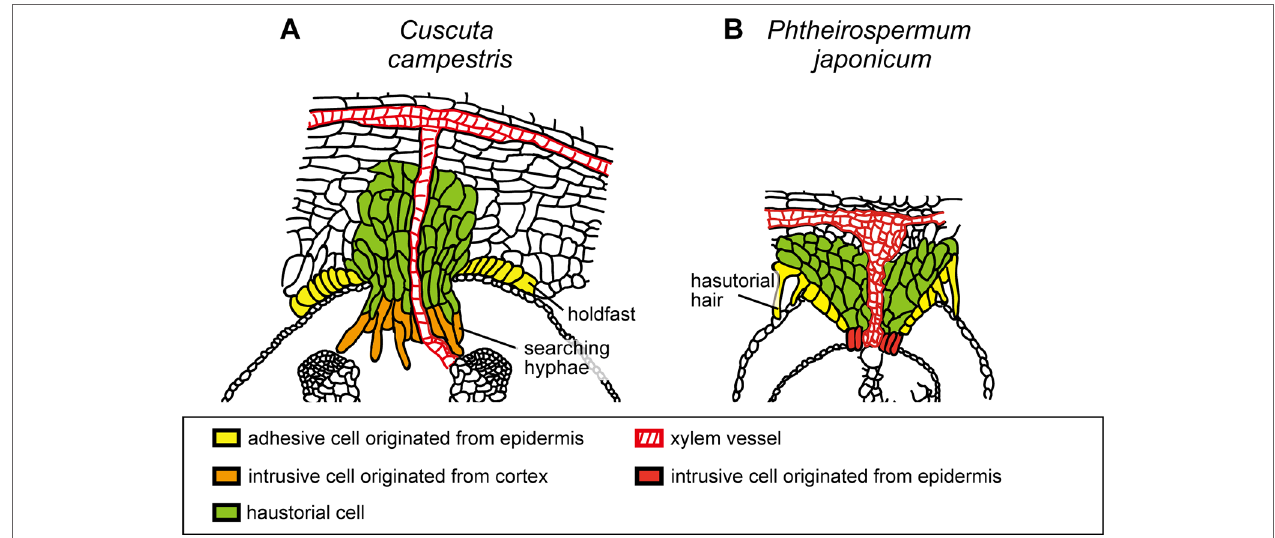
FIGURe 3 | Schematic illustration of the structures of haustoria of Cuscuta campestris and Phtheirospermum japonicum . (A) Cuscuta campestris , a holoparasitic plant belonging to Convolvulaceae, develops lateral haustoria. (B) Phtheirospermum japonicum , a hemiparasitic plant belonging to Orobanchaceae, develops lateral haustoria. Holdfast of C. campestris and haustorial hair of P. japonicum are likely to be analogous that develop from epidermal cells and contribute to the adhesion of parasite to host. Intrusive cells of C. campestris , searching hyphae, develop from digitate cells which have been differentiated from the cortex or endodermal cells of the stem. On the other hand, intrusive cells of P. japonicum are shown to be differentiated from the epidermal cells.